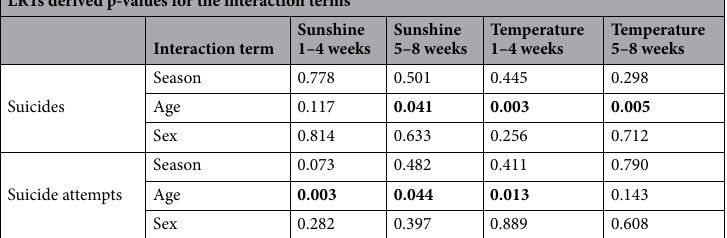
LRTs derived p-values for the interaction